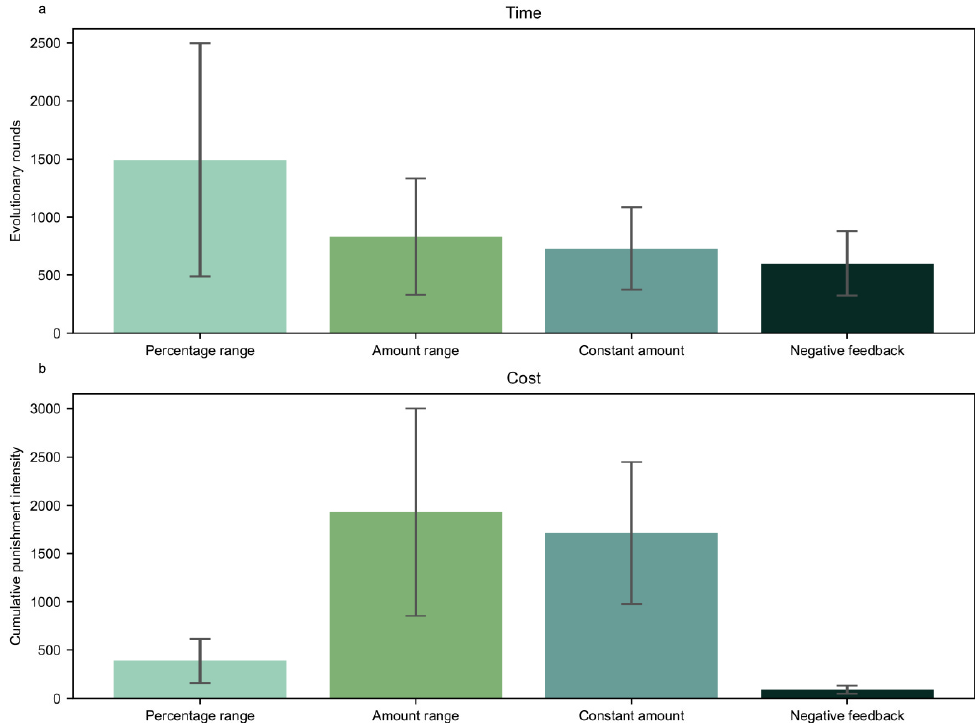
Figure 3. Comparison of the operation of sanctioning institutions under different punishment methods. Based on 50 operations of the institution, we compare the time and money consumption of several punishment methods. Bar heights in ( a , b ) indicate the mean evolutionary rounds and the average of the cumulative punishment intensity over 50 repetitions, respectively. The detailed setup of the simulation environment is shown in Appendix